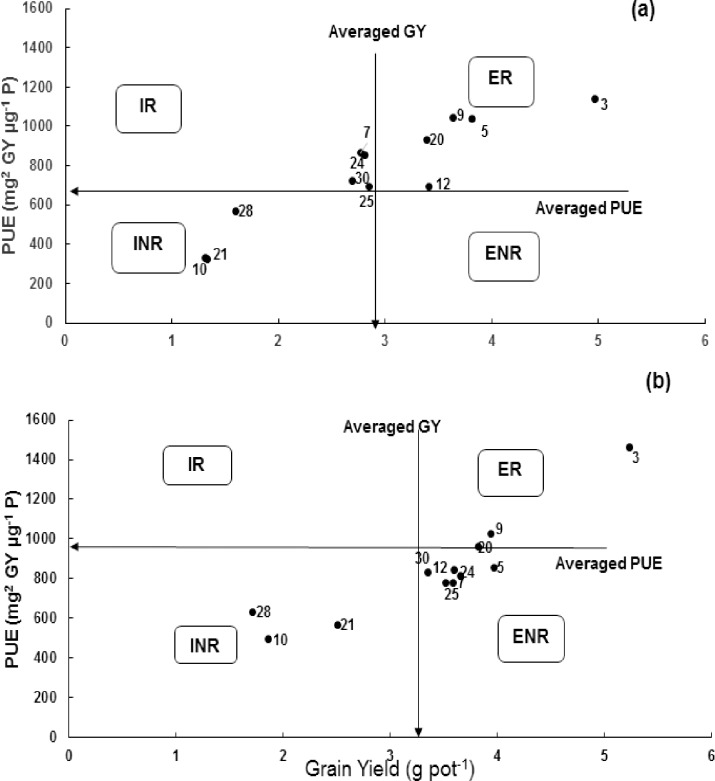
Classification of wheat genotypes at maturity (in pot culture) for P utilization efficiency a) at deficit P and b) at adequate P supply. Data are the mean value of four replicates. This categorization divides genotypes into four categories i.e. efficient and responsive (ER), in-efficient and responsive (IR), efficient and non-responsive (ENR), and in-efficient and non-responsive (INR) [28, 29].